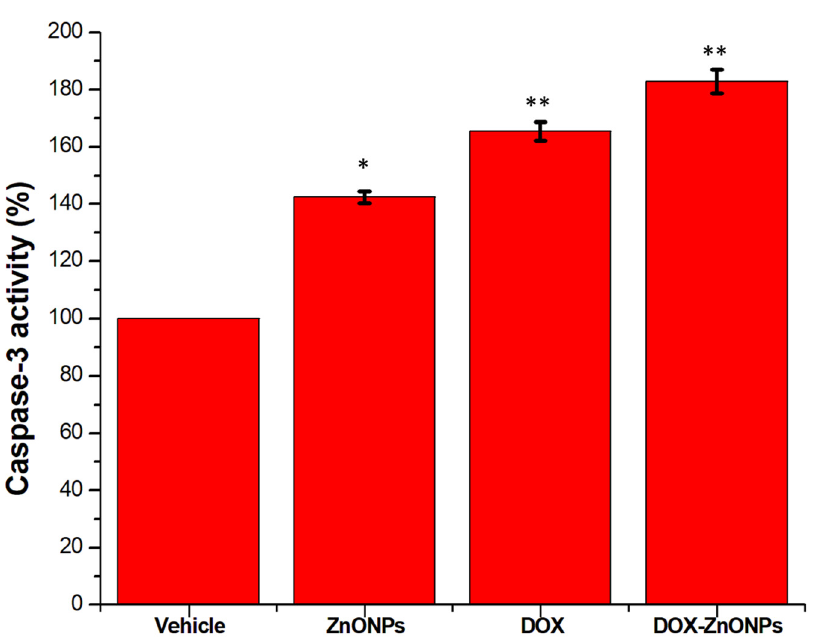
Figure 11. Caspase-3 activity in A549 cells following treatment with IC50 concentrations of ZnONPs (65.3 µ g/mL), DOX (0.56 µ g/mL) and DOX-ZnONPs (0.34 µ g/mL), for 24 h. Data shown represent mean ± standard error of mean of triplicate experiments repeated thrice. * p < 0.05, and ** p < 0.01 indicate significant differences from vehicle control group.